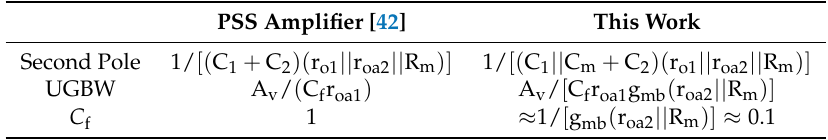
Figure 3. The gain booster provides a dominant pole ω pg and the zero of the gain booster ω zg cancels the main amplifier output node pole ω p1 , thereby making the second pole ω p2 independent of the load capacitance C L . Table 1. Compensation capacitor size comparison between the PSS amplifier and this